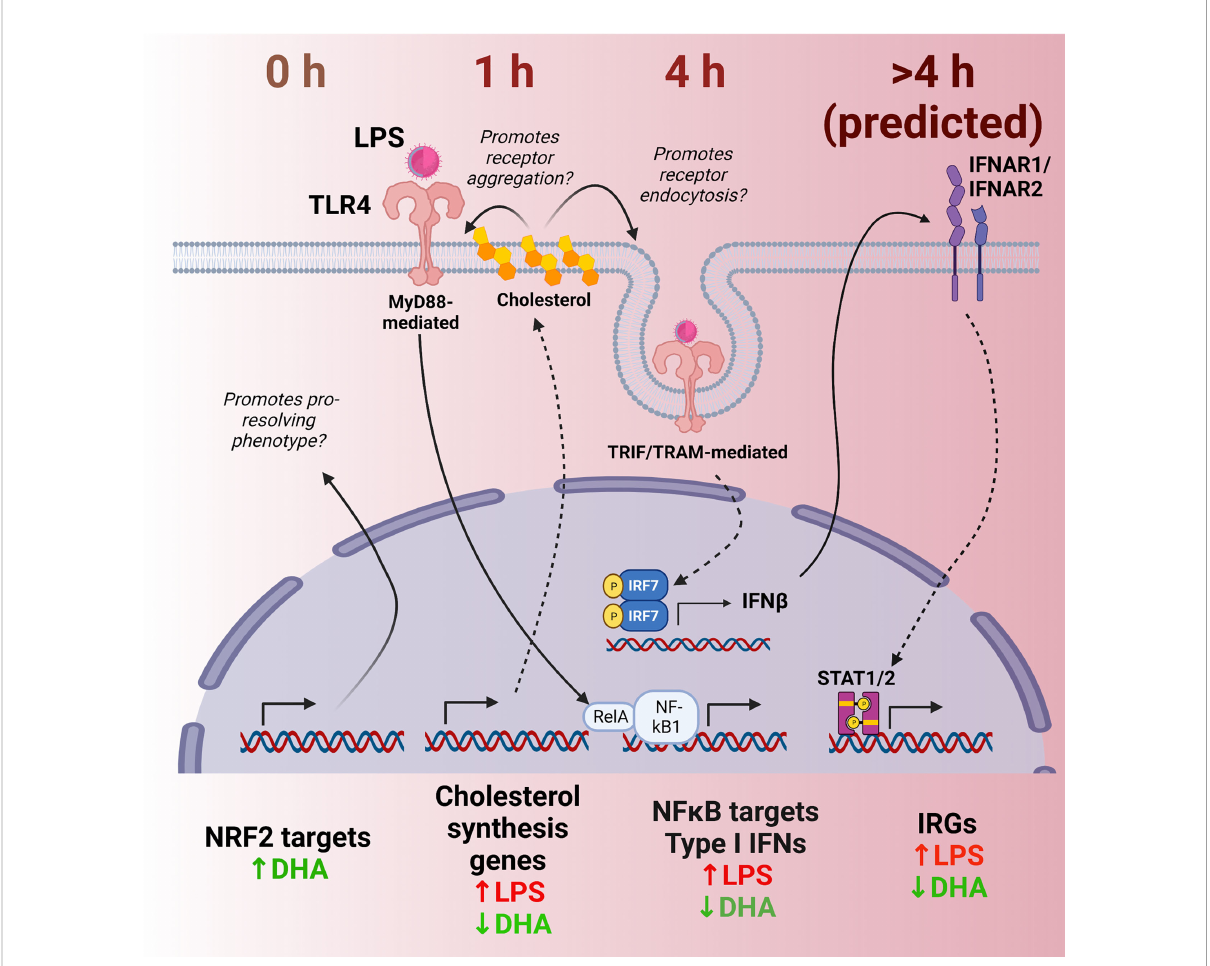
FIGURE 12 Putative model for DHA suppression of LPS-induced proin fl ammatory and IFN1-regulated gene expression in the macrophage. Time-dependent transcriptional changes elicited by DHA and/or LPS reveal multiple potential mechanisms by which DHA may counteract the in fl ammatory response to LPS. First, at 0 h (in the absence of LPS), DHA triggers expression of NRF2 target genes, which may promote a pro-resolving macrophage phenotype. At 1 h following LPS exposure, DHA suppresses LPS-triggered cholesterol genes, which may prevent cholesterol- mediated facilitation of further TLR4 signaling. At 4h following LPS exposure, DHA downregulates NF- k B-target and IFN1-regulated gene (IRGs) including IFN- b , likely preventing robust induction of further IFN-response at ≥